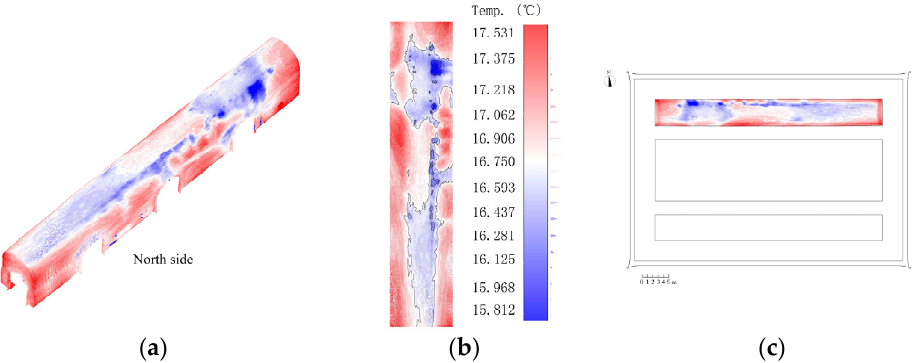
Figure 7. Moisture distribution analysis at the top of NA (pseudocolours show the temperature val- ues). ( a ) Three-dimensional point-cloud model. ( b ) View of vault expansion. ( c ) Bottom view.